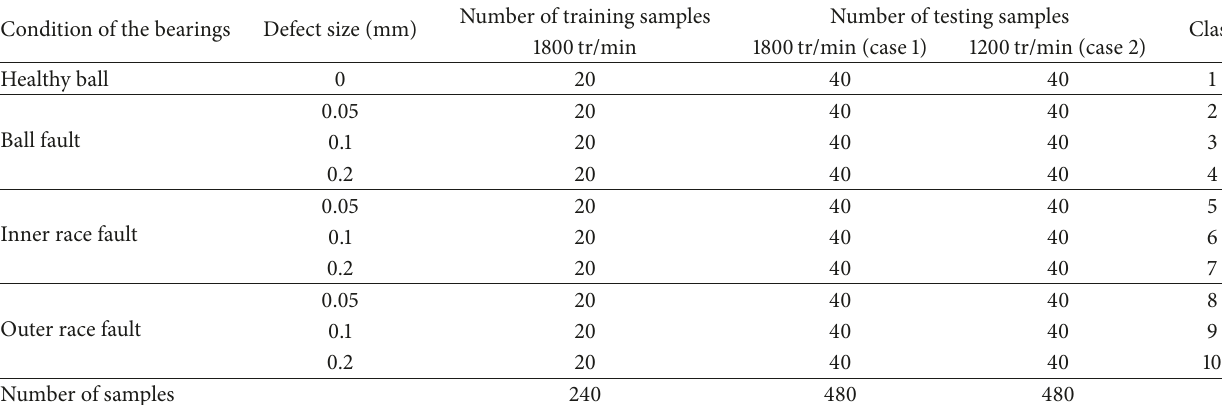
Table 13: The detailed information of the used vibration